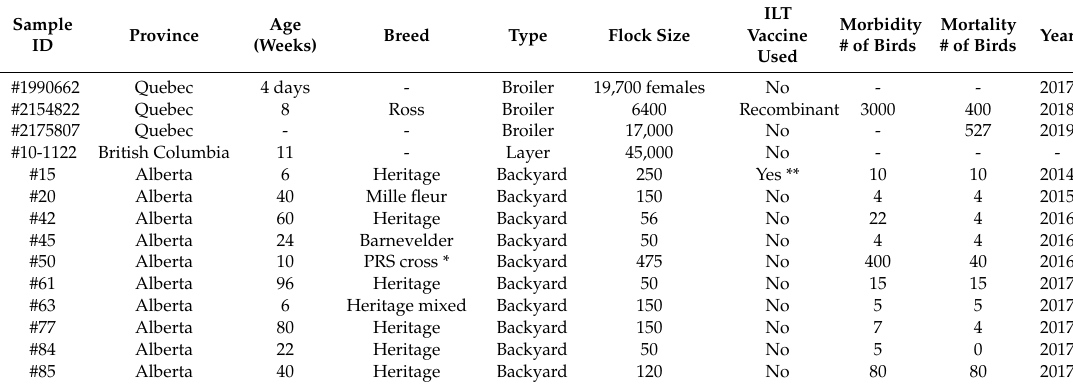
Table 1. Relevant background information of the poultry farms from which the 14 Canadian infectious laryngotracheitis virus (ILTV) samples that yielded full genome sequences originated. Dash lines fill slots where information could not be obtained.